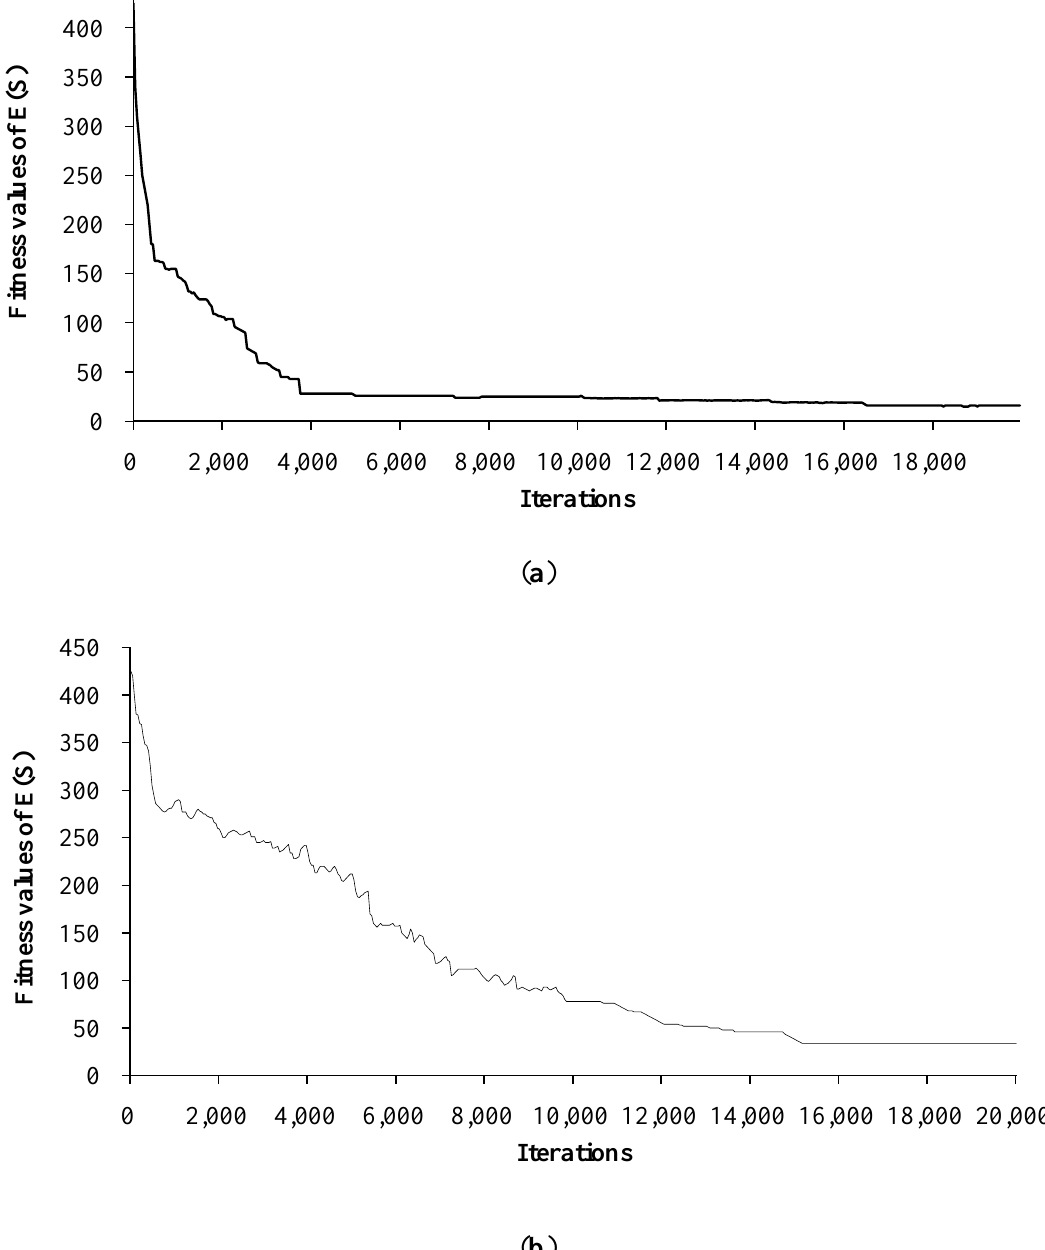
Figure 13. Comparative analysis between ( a ) the modified SA and ( b ) the standard